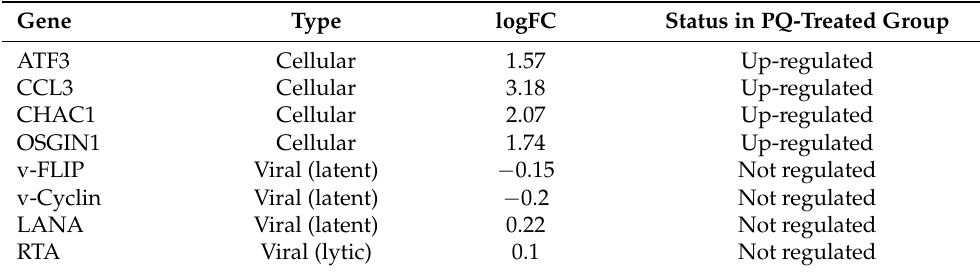
Table 2. RNA-seq analysis of the main differentially modulated cellular and viral genes from PQ- treated BC-3 cells. RNA-seq analysis of transcriptional expression regulation of the four main cellular genes, ATF3, CCL3, CHAC1, and OSGIN1, and of the three main latent viral genes, LANA, v-FLIP, and v-cyclin and the main lytic viral gene Rta in PQ-treated BC-3 cells compared to untreated control. Their type, log of fold change, and status of regulation in PQ-treated group compared to untreated control group are shown. ATF3, activating transcription factor; CCL3, MIP-1- α , macrophage inflammatory protein1- α ; CHAC1, cation transport regulator-like 1; OSGIN1, oxidative stress-induced growth inhibitor 1; v-FLIP, viral Fas-associated protein with death domain-like interleukin-1 β -converting enzyme/caspase-8-inhibitory protein; v-cyclin, viral cyclin; LANA, Latency-Associated Nuclear Antigen; RTA, Replication and Transcription